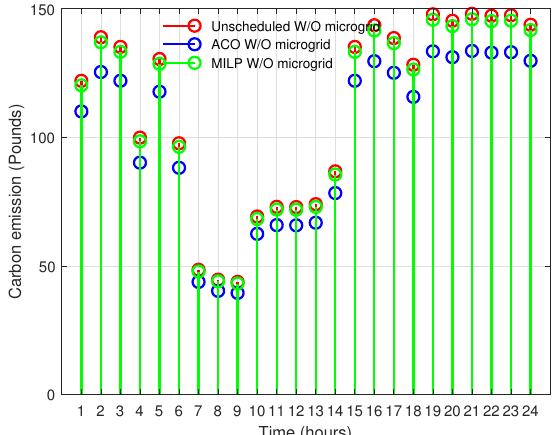
Figure 10. Comparative evaluation of carbon emission